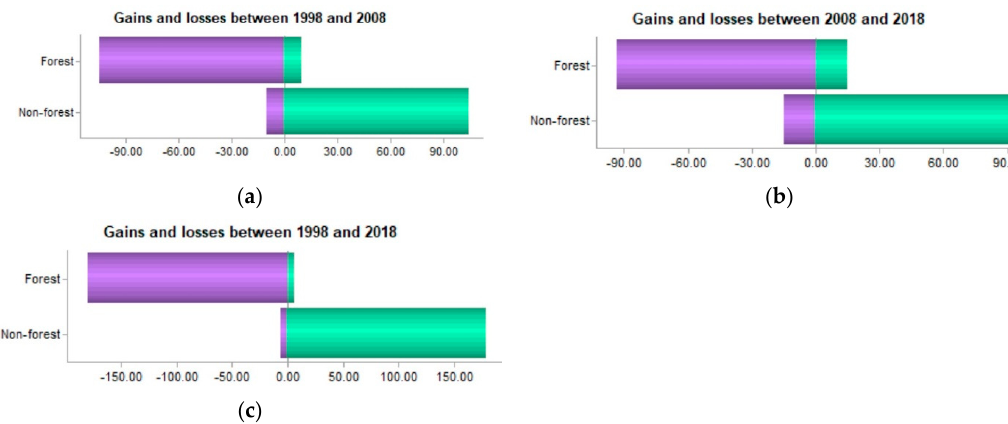
Hydrology 2019 , 6 , x Figure 6. Gains and losses (in km 2 ) in the year ( a ) 1998–2008, ( b ) 2008–2018, and ( c ) 1998–2018. It can be seen from the land change maps that there were substantial losses of forest cover and reciprocal gains in non-forest cover in all periods. The LULC change and gains and losses maps of each class (forest and non-forest) from 1998–2018 are shown in Figure 7a–c. Figure 6. Gains and losses (in km 2 ) in the year ( a ) 1998–2008, ( b ) 2008–2018, and ( c ) 1998–2018.